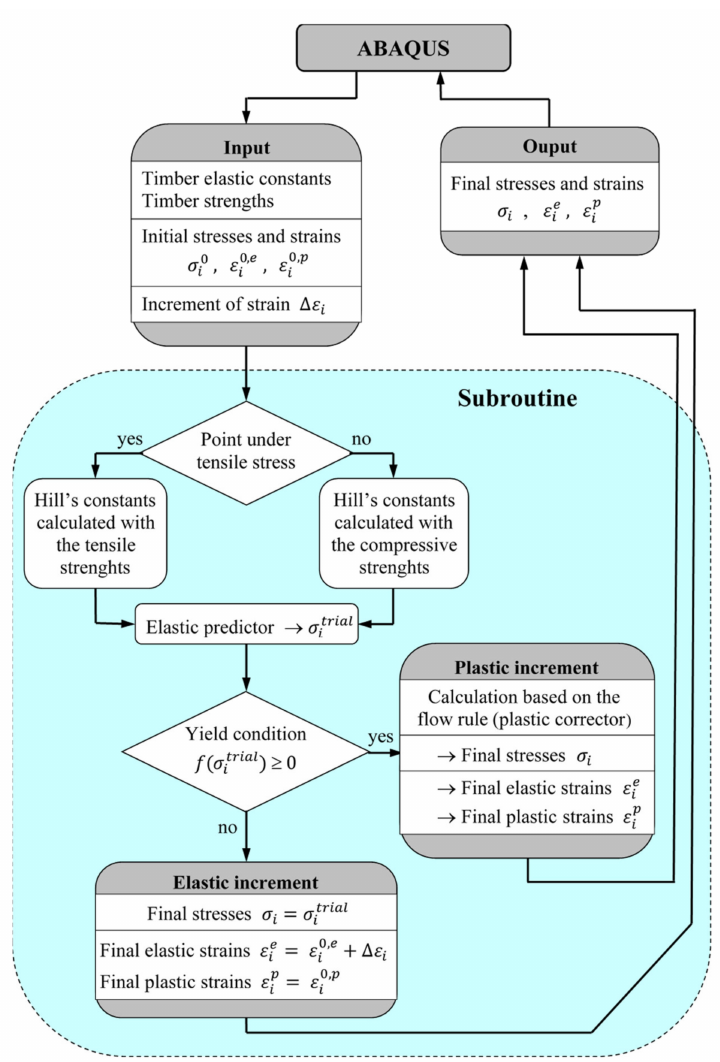
Figure 9. Flow chart of the subroutine developed for modeling the mechanical behavior of